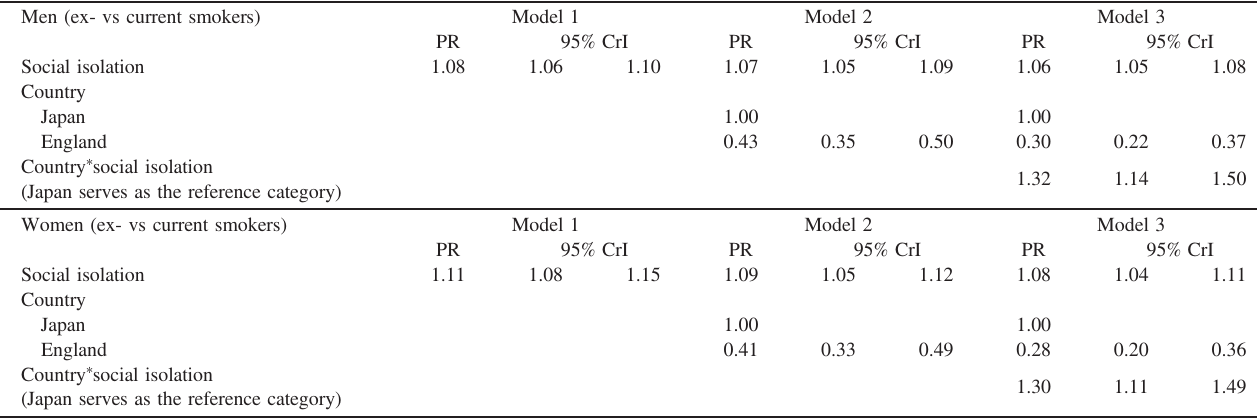
Table 3. Smoking status (ex- vs current smokers) and social isolation as a function of sex for the multiply imputed data (multilevel Poisson regression